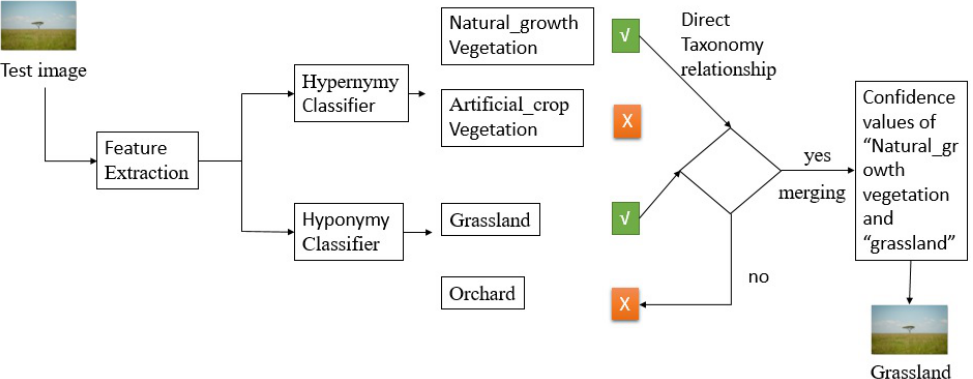
Figure 6. Classification using merging classifiers.